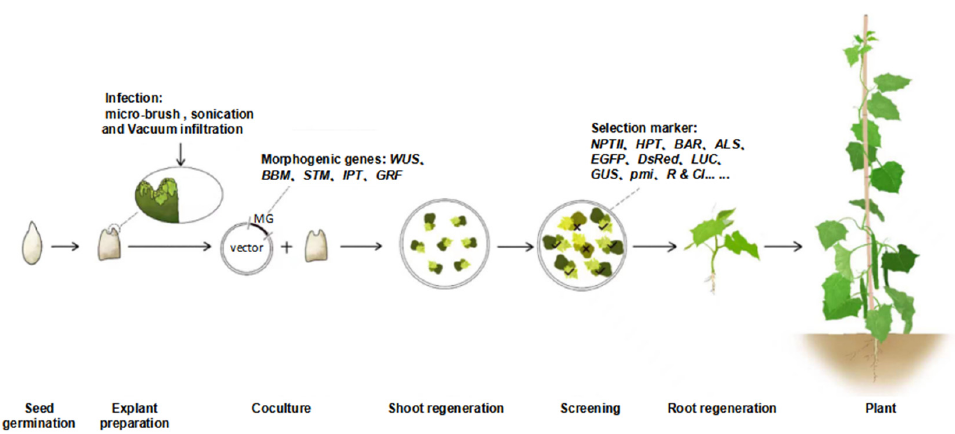
Figure 1. Efficient methods for the genetic transformation of cucurbit crops.